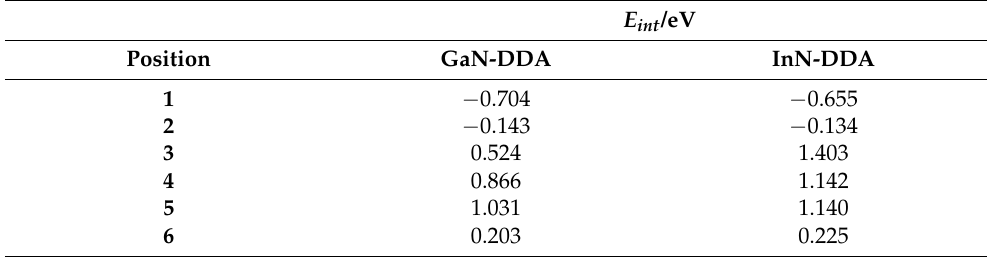
Table 1. The energy of interaction associated with each binding site is shown in Figure